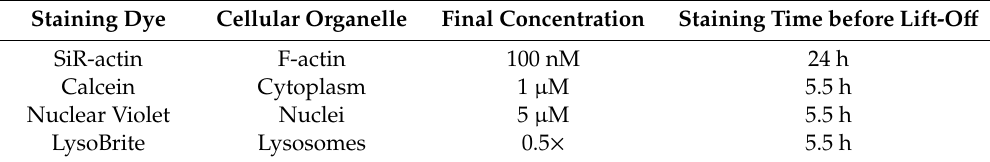
Table 1. Overview of applied live cell staining dyes, concentrations and staining times.